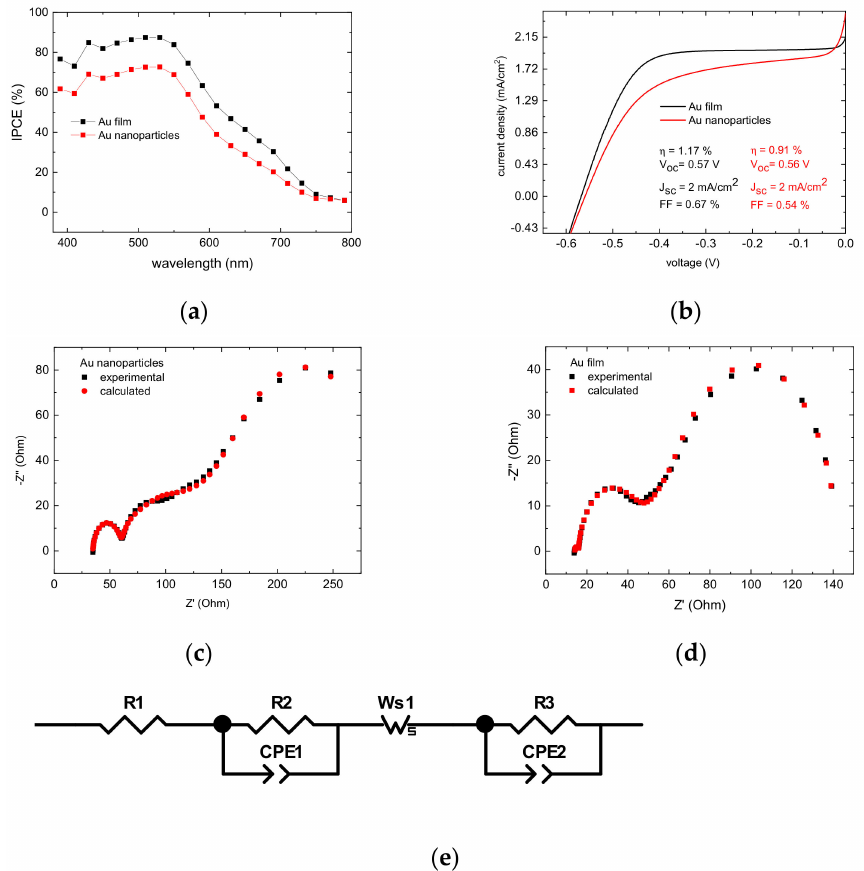
Figure 8. ( a ) Photo-action spectra in the presence of the two different catalytic CEs: Au film (black) and Au nanoparticles (red) ( b ) Representative current density–voltage (J-V) curves in the presence of the two different CEs: nanoparticles (red); film (black) ( c , d ) Complex plane plots of Cobalt mediated DSSC at Voc in the presence of two different types of counter-electrodes: Au nanoparticles/FTO ( c ) and Au film ( d ). ( e ) Equivalent circuit used to fit the EIS response of the DSSCs at